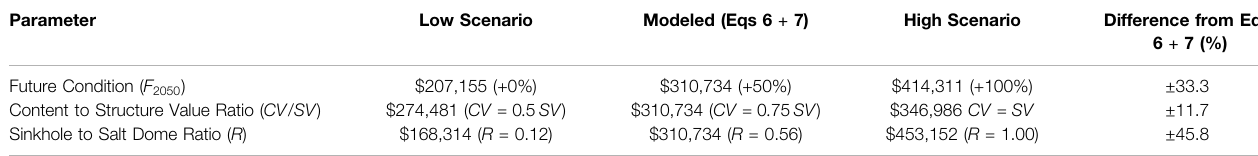
TABLE 2 | Sensitivity analysis of 2050 projections of Louisiana statewide annual property loss (i.e., risk) due to sinkhole, by parameter (2010$).